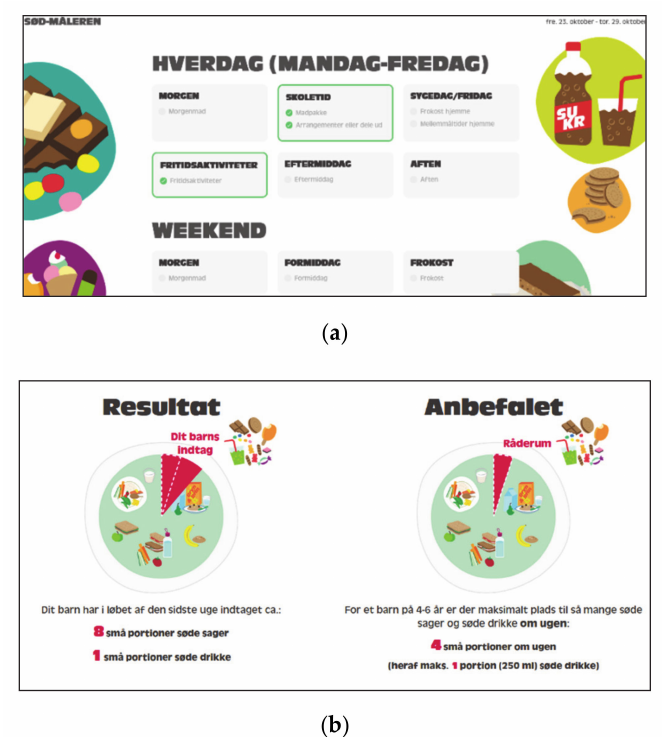
Figure 3. Screenshots of the sugar-rich food screener. It assesses one week’s intake of discretionary food and is completed in approximately 10 min. ( a ) The sugar-rich food screener is non-linear and can be completed in the order participants prefer. ( b ) When completed, the last page illustrates how many serving sizes the child has consumed, and the share that the sugar-rich food and drinks take up from other food compared to